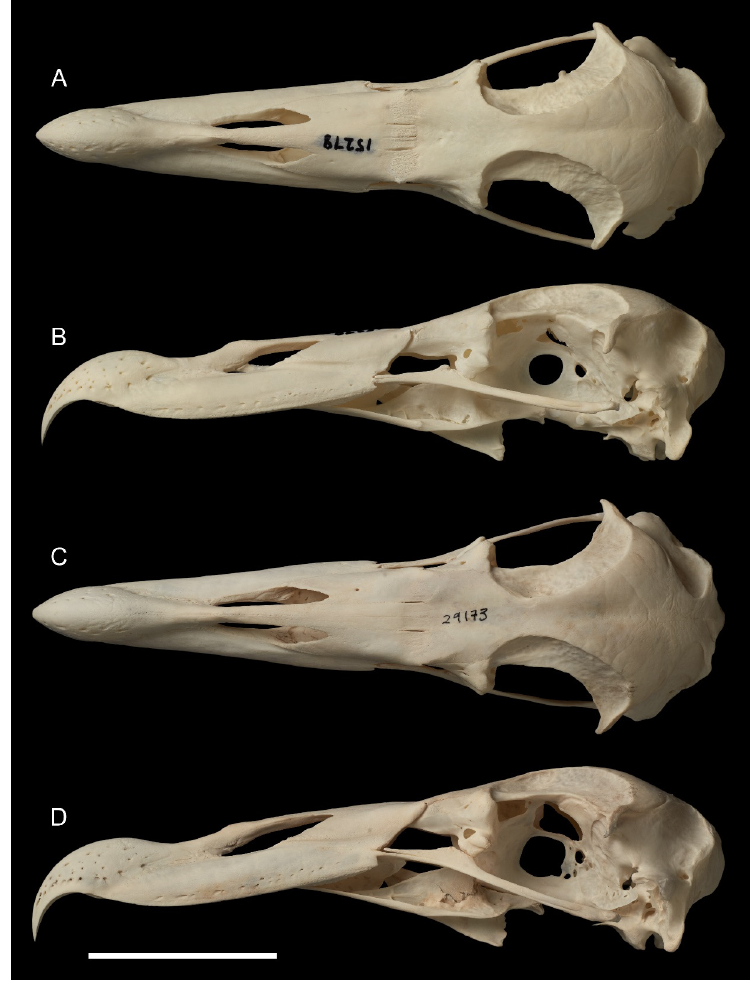
Figure 2. Skulls (except mandible) of Macronectes spp.; scale bar = 5 cm. ( A , B ) M. giganteus , NMNZ OR.015278. ( C , D ) M. halli , NMNZ OR.029173.